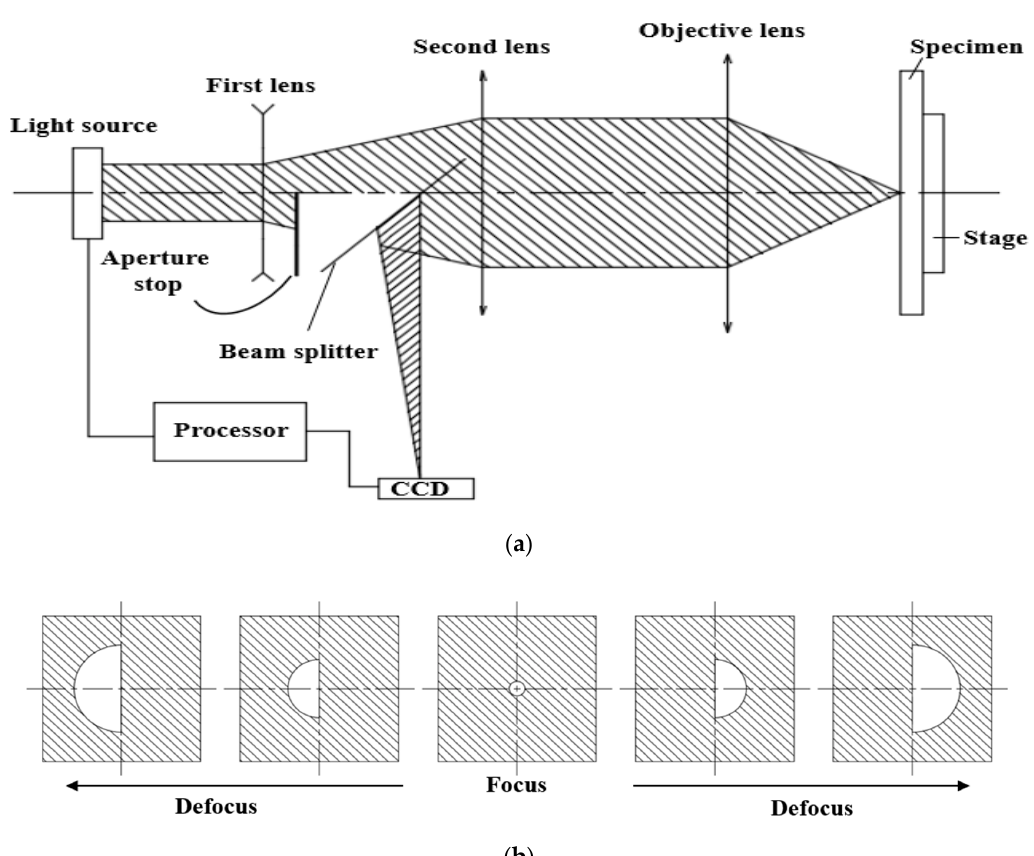
Figure 1. ( a ) Schematic of the autofocusing system developed by Metrology Sensors GmbH (MSG); ( b ) Variation in the bisected beam spot acquired on the CCD camera when the specimen is positioned at the focus and at different defocus distances.